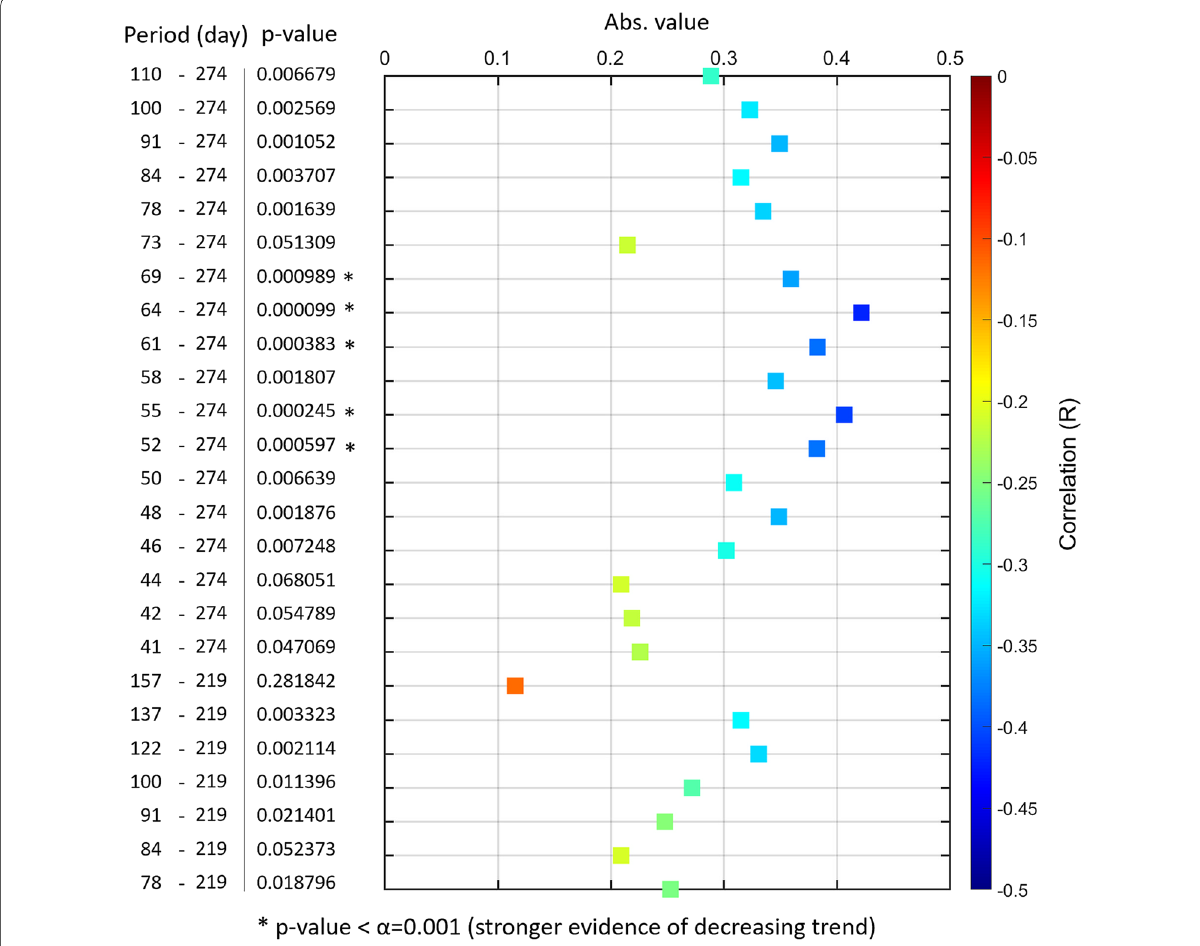
Fig. 6 Correlation values and p -values for a range of period bands listed in Additional file 2: Table S1. The period displays within 78–274 period band, the p -values less than 0.001 is marked by the